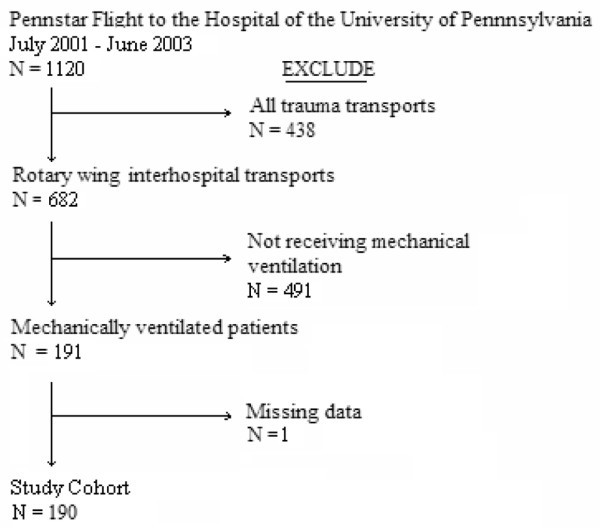
Diagram of patient accrual.